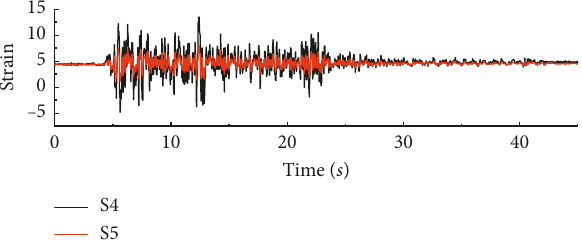
Figure 12: Time history of dynamic strain at S4 and S5 mea- surement points at the soil-rock partition